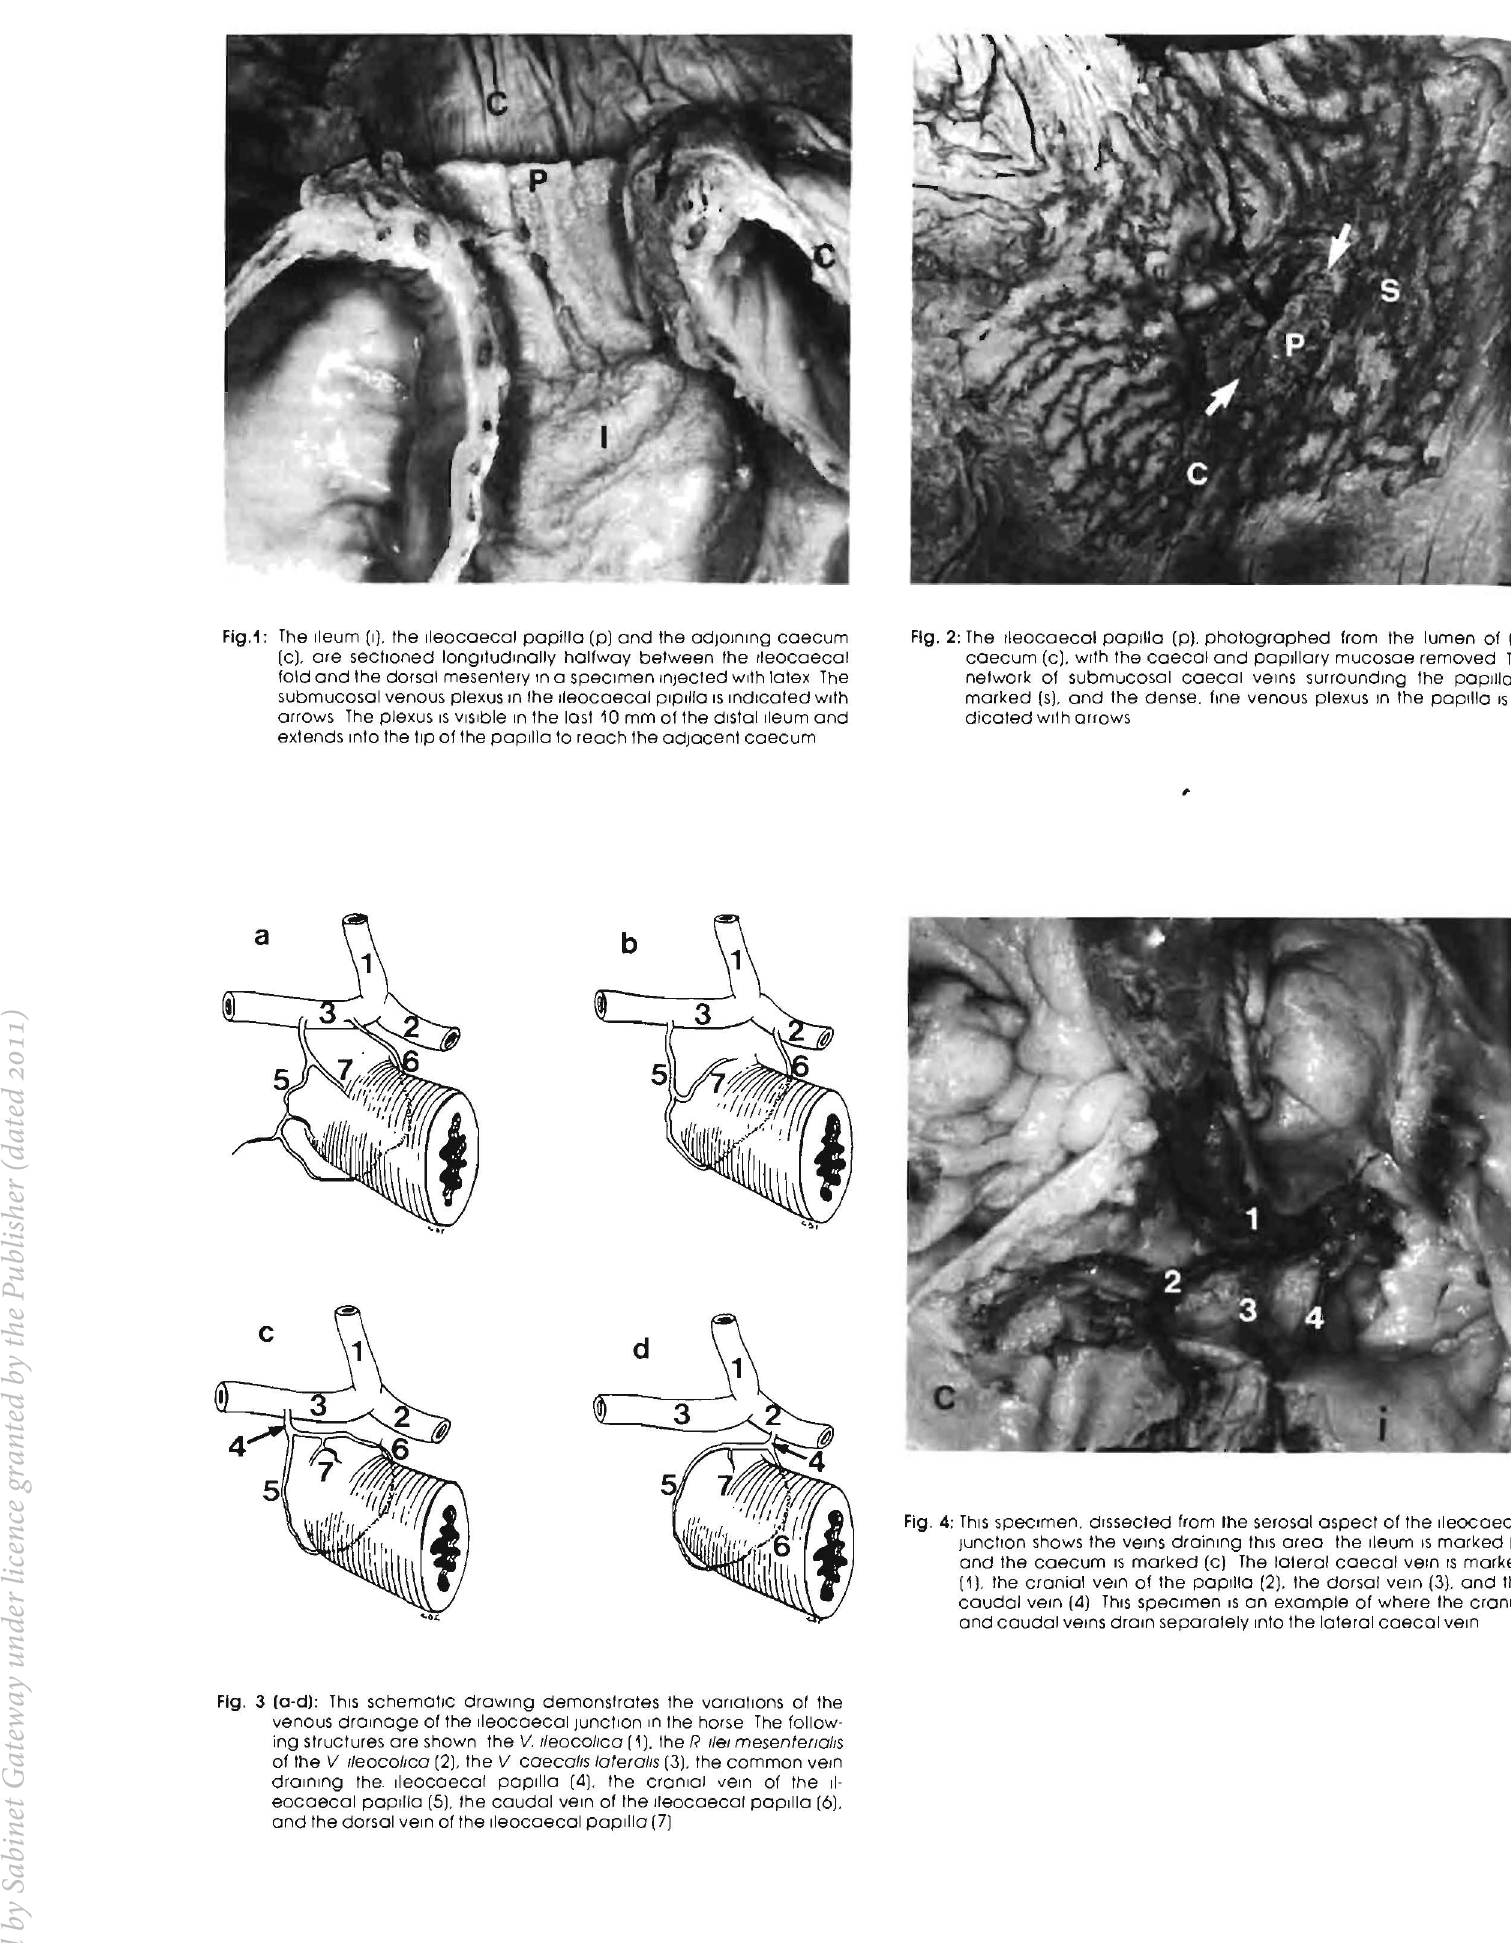
Fig. 3 (a-d): This schematic draWing demonstrates the vanallons of the venous drainage of the lIeocaecal Junction In Ihe horse The follow· ing structures are shown the V. Ileocolic a (1). Ihe R Ilel mesen/ellalls of the V Ileocohca (2). the V caecalls la/erahs (3). the common vein draining the. lIeocaecal papilla (4). the cranial vein of the II· eocaecal papilla (5). the caudal vein of Ihe rleocaecal papilla (6). and the dorsal vein of the Ileocaecal papilla (7)